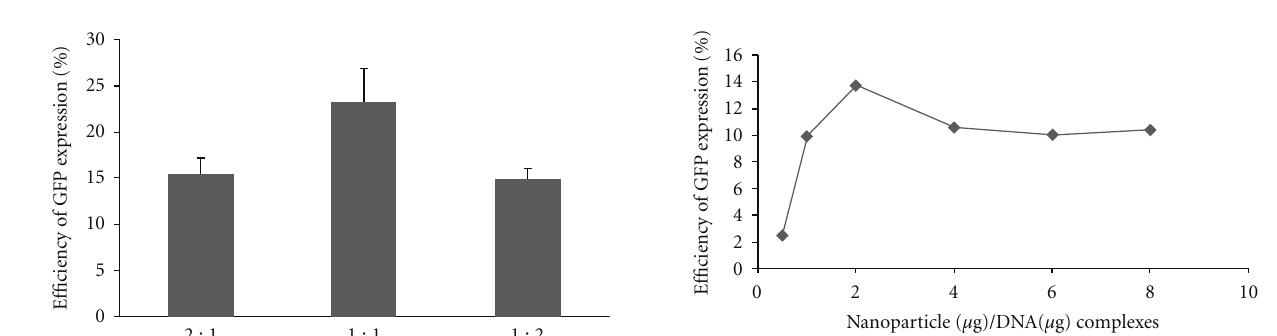
Figure 5: Expression e ffi ciencies of GFP plasmid at di ff erent ratio of nanoparticles and plasmid DNA. The e ffi ciency of GFP expression was influenced by the mass ratio of nanoparticles and plasmid DNA.